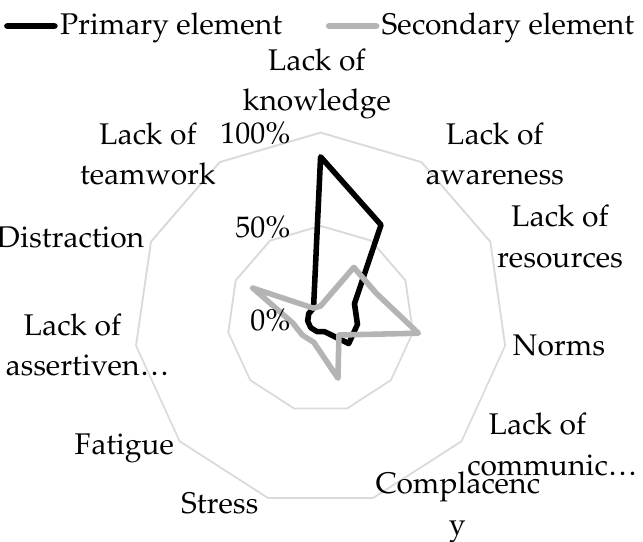
Figure 3. Representation of primary and secondary causation in the reviewed occurrence reports.